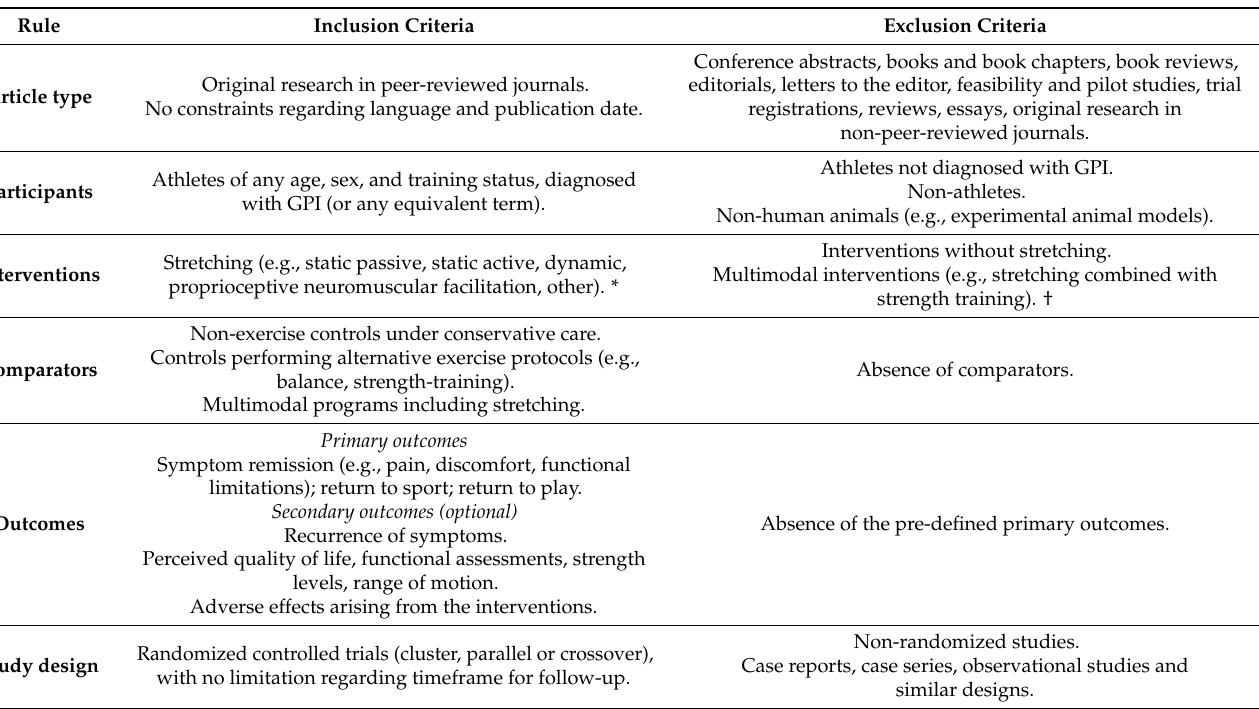
Table 1. Inclusion and exclusion criteria based on scope and